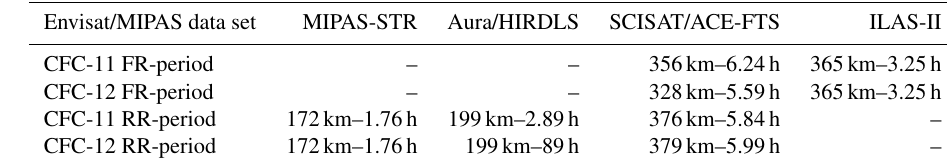
Table 2. Mean matching distance and time for comparisons based on collocated measurements.